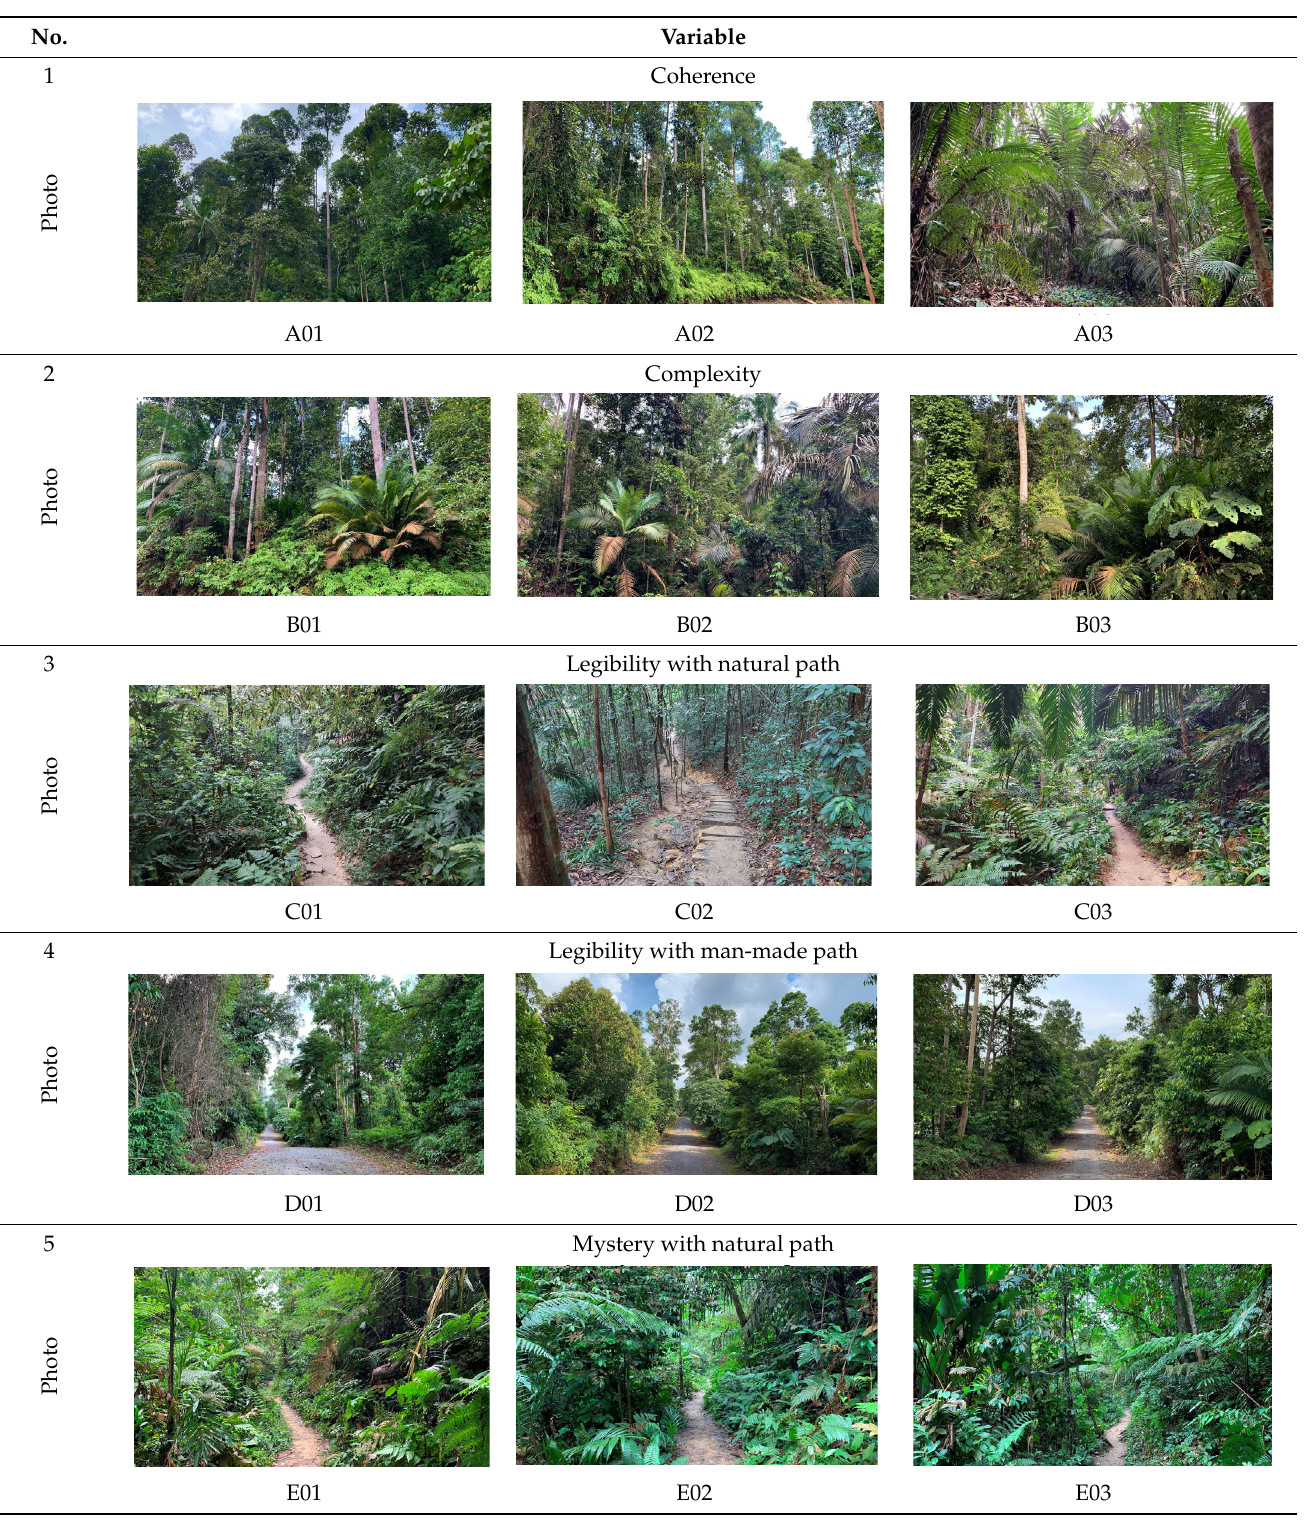
Table A1. The unique code of each of photo.